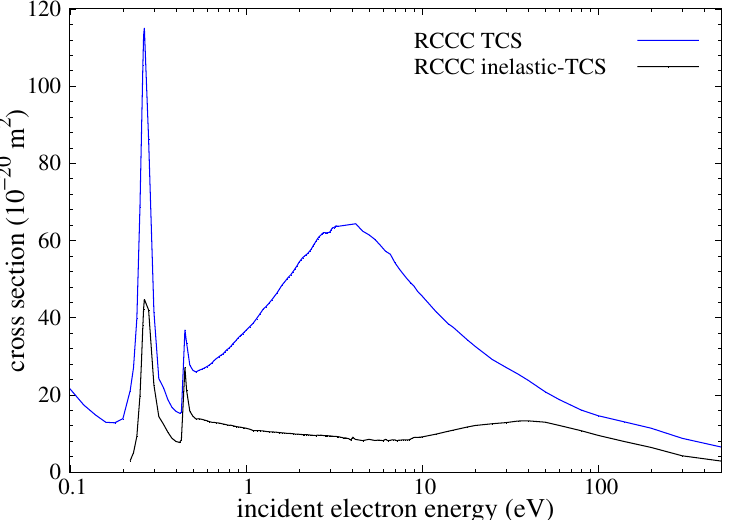
Figure 17. RCCC results for integrated total cross section and inelastic total cross section for scattering on the 3 P 0 ground